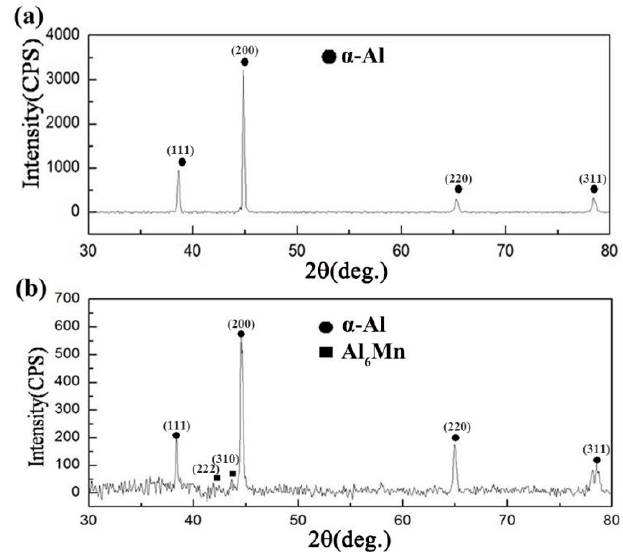
Figure 1. X-ray di ff raction (XRD) pattern of suction casting alloys: ( a ) Al–1.8 wt.% Mn alloy; Figure 1. X-ray diffraction (XRD) pattern of suction casting alloys: ( a ) Al–1.8 wt.% Mn alloy; ( b ) Al–4 ( b ) Al–4 wt.% Mn wt.% Mn alloy.